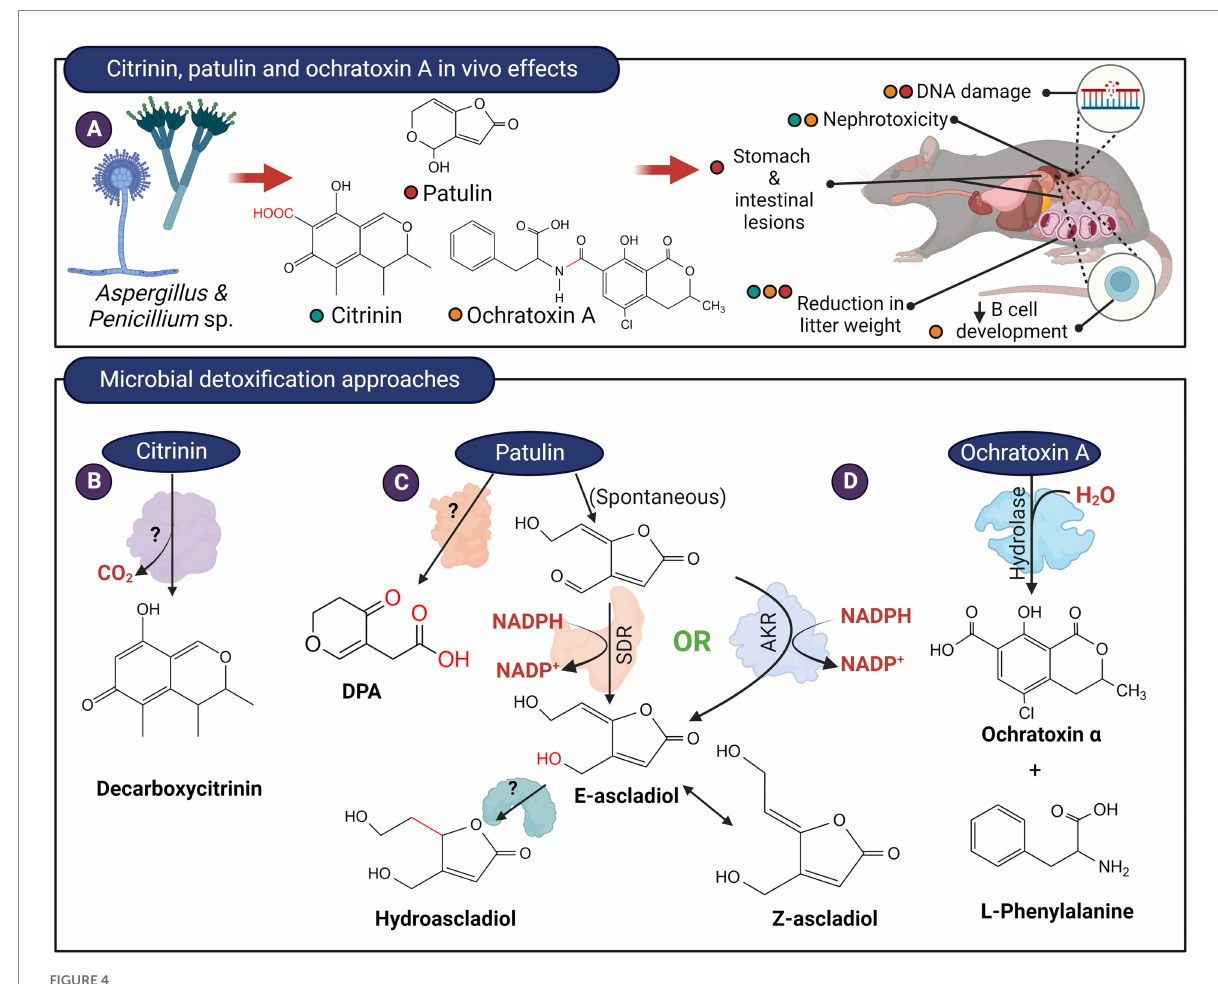
FIGURE 4 In vivo effects of citrinin, patulin, ochratoxin and microbial detoxification approaches. (A) These mycotoxins are produced by members of Aspergillus and Penicillium and typically, citrinin and ochratoxin possess nephrotoxic effects while patulin exerts serious gastrointestinal effects. (B) Decarboxylation of citrinin to decarboxycitrinin. (C) The hemiacetal ring of patulin likely exist in equilibrium with the ring-open form. The aldehyde in the ring-opened form of patulin can be reduced by enzymes from the short-chain dehydrogenase (SDR) or aldo-keto reductase